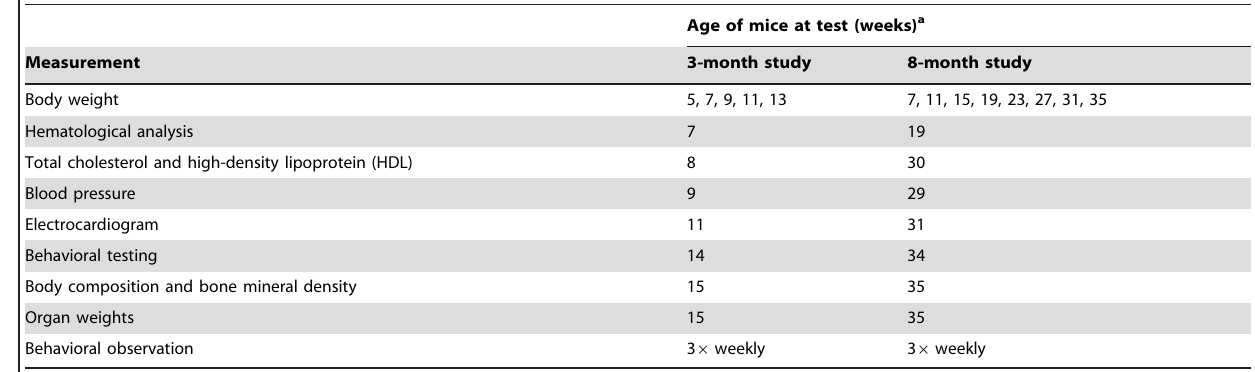
Table 2. Schedule of